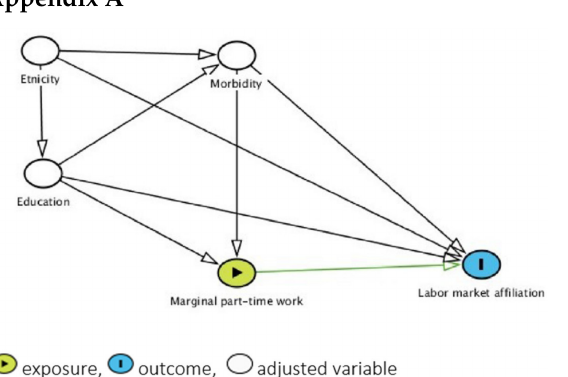
Figure A1. Directed acyclic graph of marginal part-time work and labor market affiliation in gender and age groups.